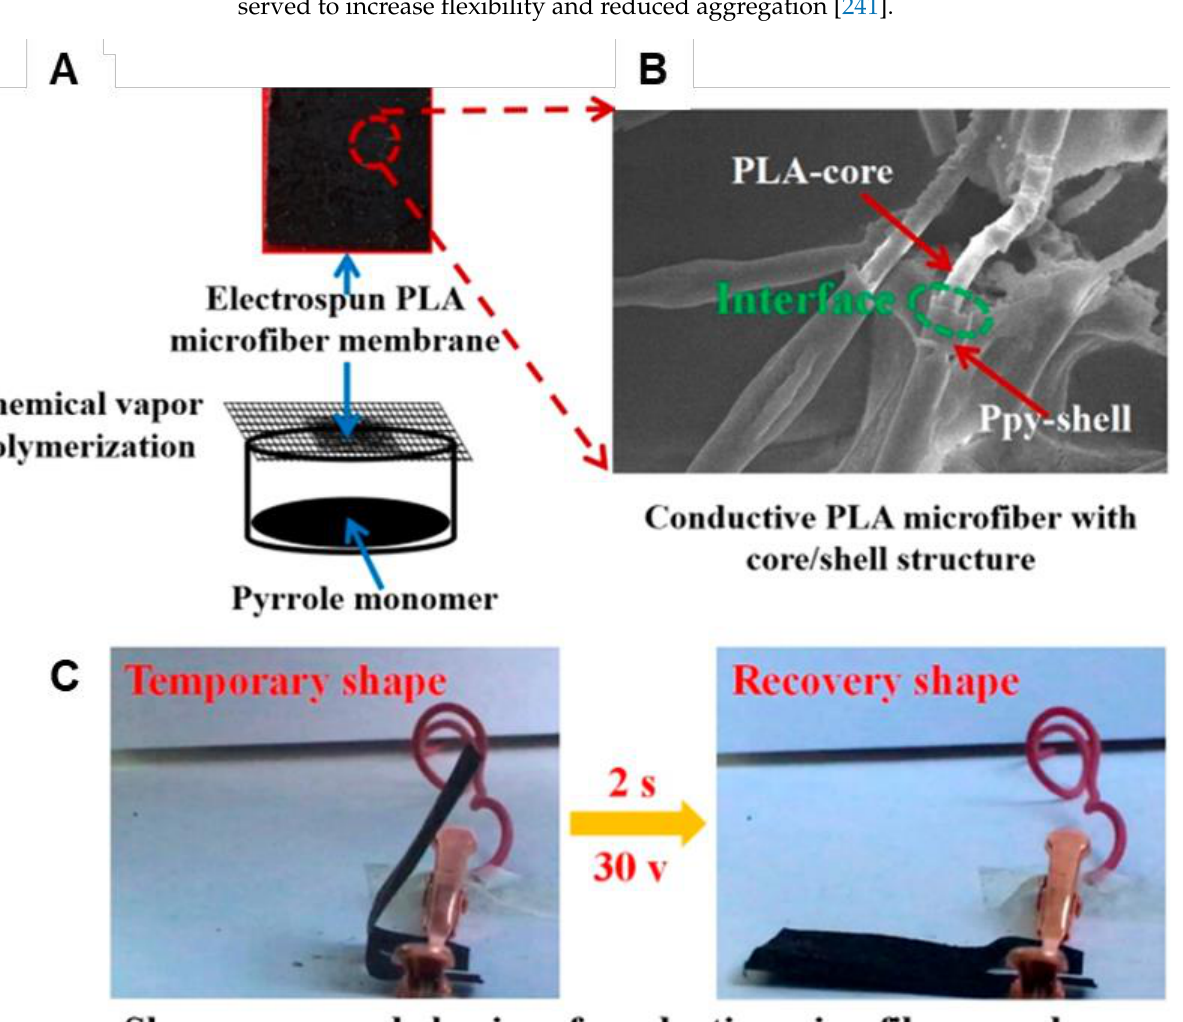
Figure 25. Shape memory device constructed from PPy coated on electrospun PLA [277]: ( A ) schematic of in situ polymerization of PPy onto electrospun PLA; ( B ) SEM image showing core/shell structure of nanocomposite with PLA as the core and PPy as the shell; ( C ) effect of application and removal of 30 V across composite resulting from the conduction of a heat-generating electric current. Reprinted with permission from [277]. Copyright 2018, American Chemical Society.